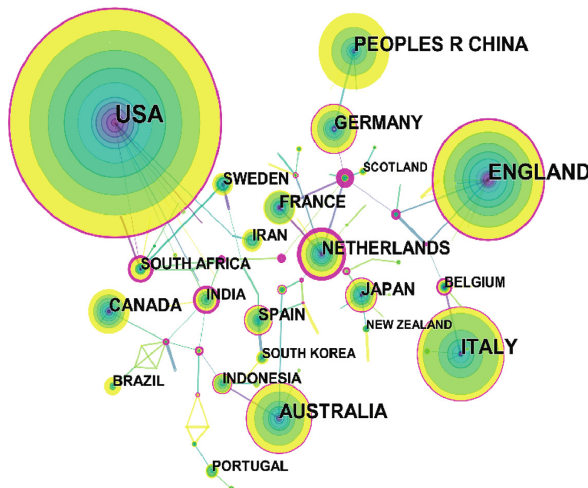
Figure 4: Visualization map of main countries in resilient city research from 2010 to